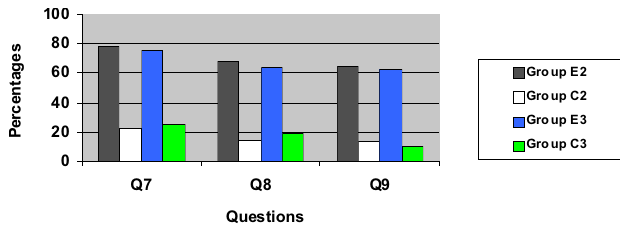
FIG. 3. (cid:1) Color (cid:2) Percentages of correct answers on electrical in- fluence body A (cid:1) with charge −Q (cid:1) nearby, as there will be a